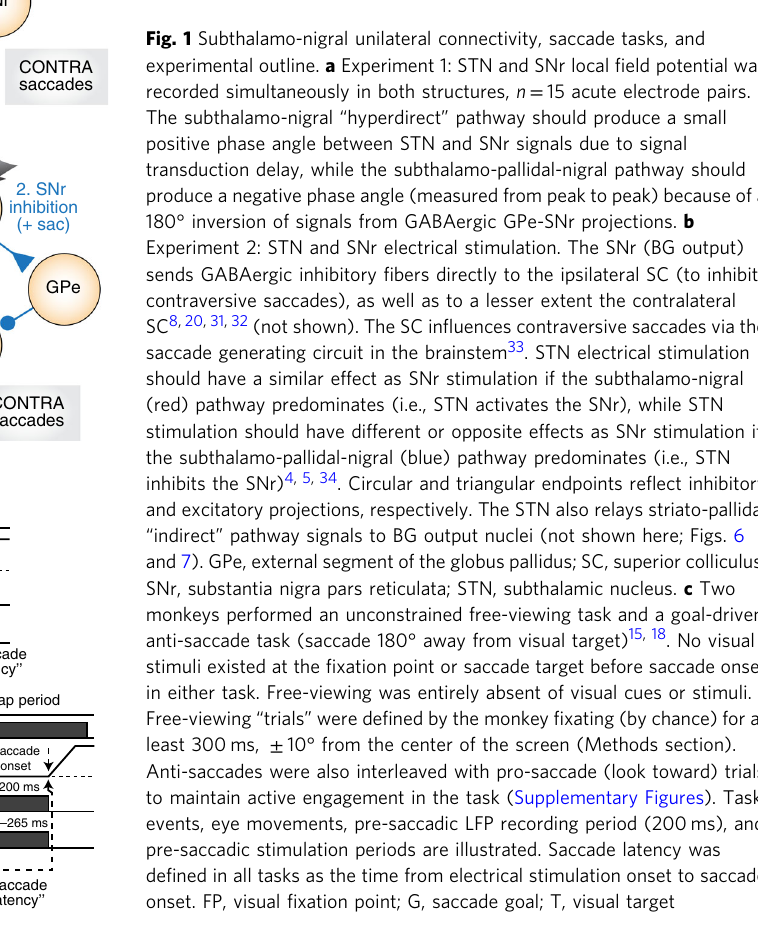
Fig. 1 Subthalamo-nigral unilateral connectivity, saccade tasks, and experimental outline. a Experiment 1: STN and SNr local fi eld potential was recorded simultaneously in both structures, n = 15 acute electrode pairs. The subthalamo-nigral “ hyperdirect ” pathway should produce a small positive phase angle between STN and SNr signals due to signal transduction delay, while the subthalamo-pallidal-nigral pathway should produce a negative phase angle (measured from peak to peak) because of a 180° inversion of signals from GABAergic GPe-SNr projections.